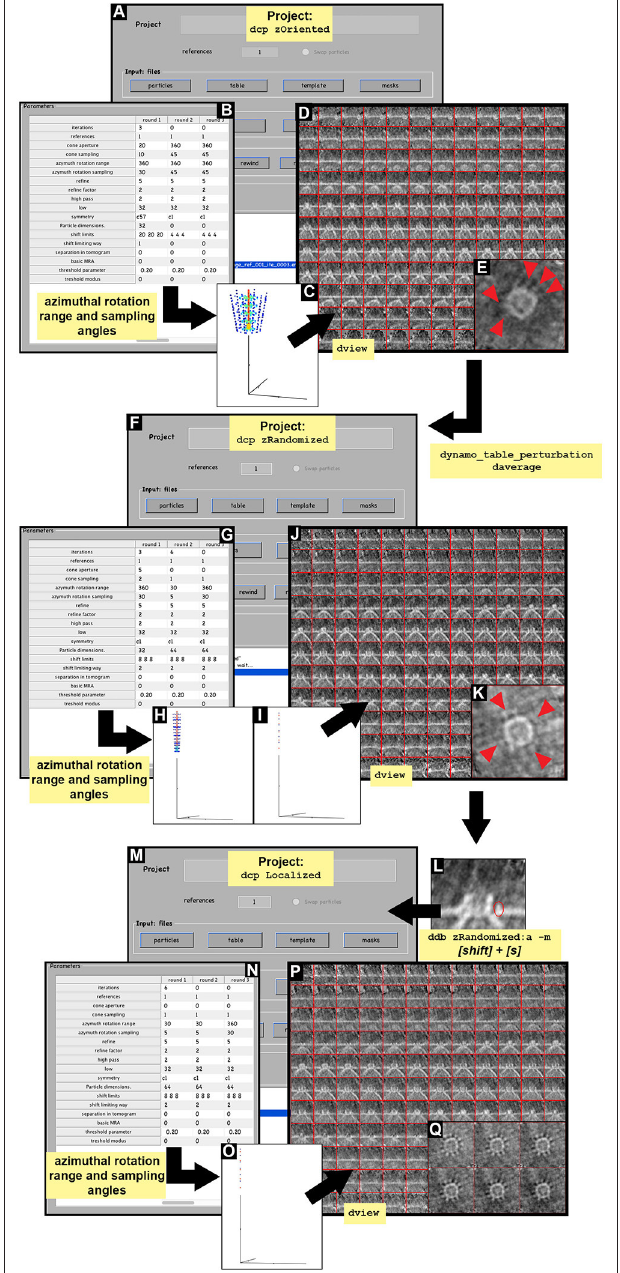
FIGURE 5 | STA projects. Visual pipeline describing the basic steps applied during the STA projects to obtained detailed ultrastructural information. (A–E) Basic steps summarizing the design of the STA project zOriented . (A) zOriented project GUI where a particle data, table (zOriented.tbl) , template (zOriented.em) and mask (default) are used to generate an average. (B) Numerical parameters used in (A) . (C) Graphical representation of the angle search mode defined in (B) concerning cone aperture and cone sampling as well as azimuthal rotation range and azimuthal sampling angles. (D) Y view of the average obtained as the result of running the STA project zOriented . (E) Z view of average slice number 66 in dmapview obtained in (D) , red arrowheads (Continued)